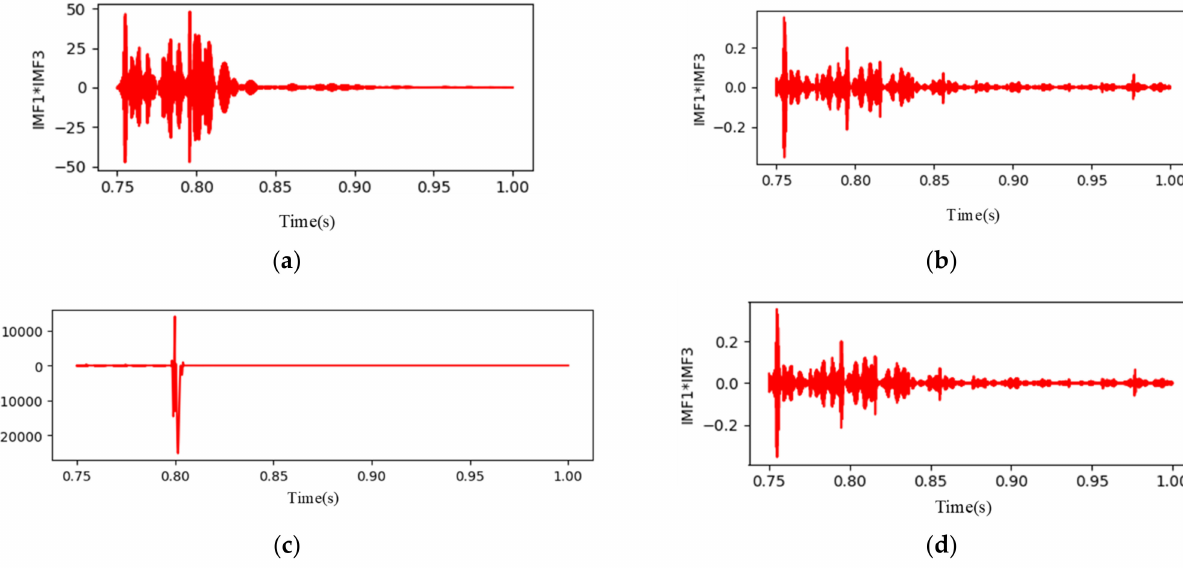
Figure 9. The results of IMF1 times IMF3: ( a ) case A; ( b ) case B; ( c ) Case C; ( d ) case